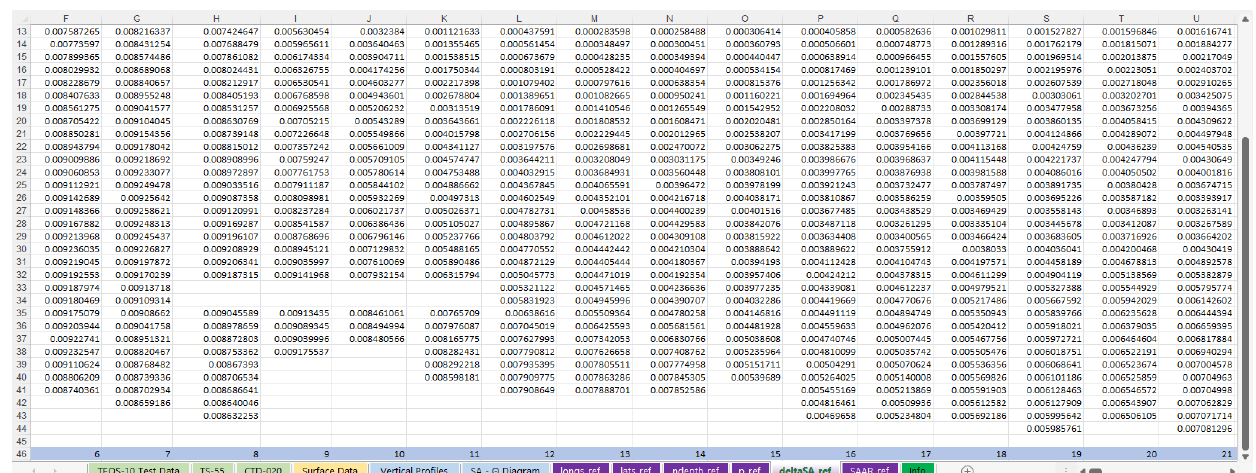
Figure 8. The [deltaSA_ref] table: reference data missing for pressure levels 33 and 34 of columns 8, 9, 10, and 11.